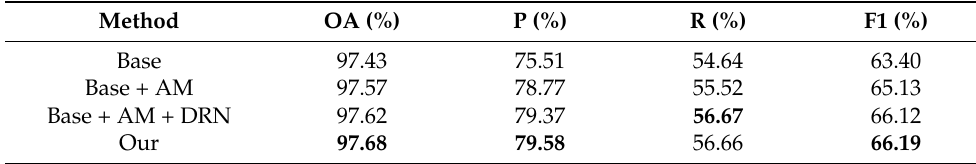
Table 3. Results of the ablation study on the Massachusetts